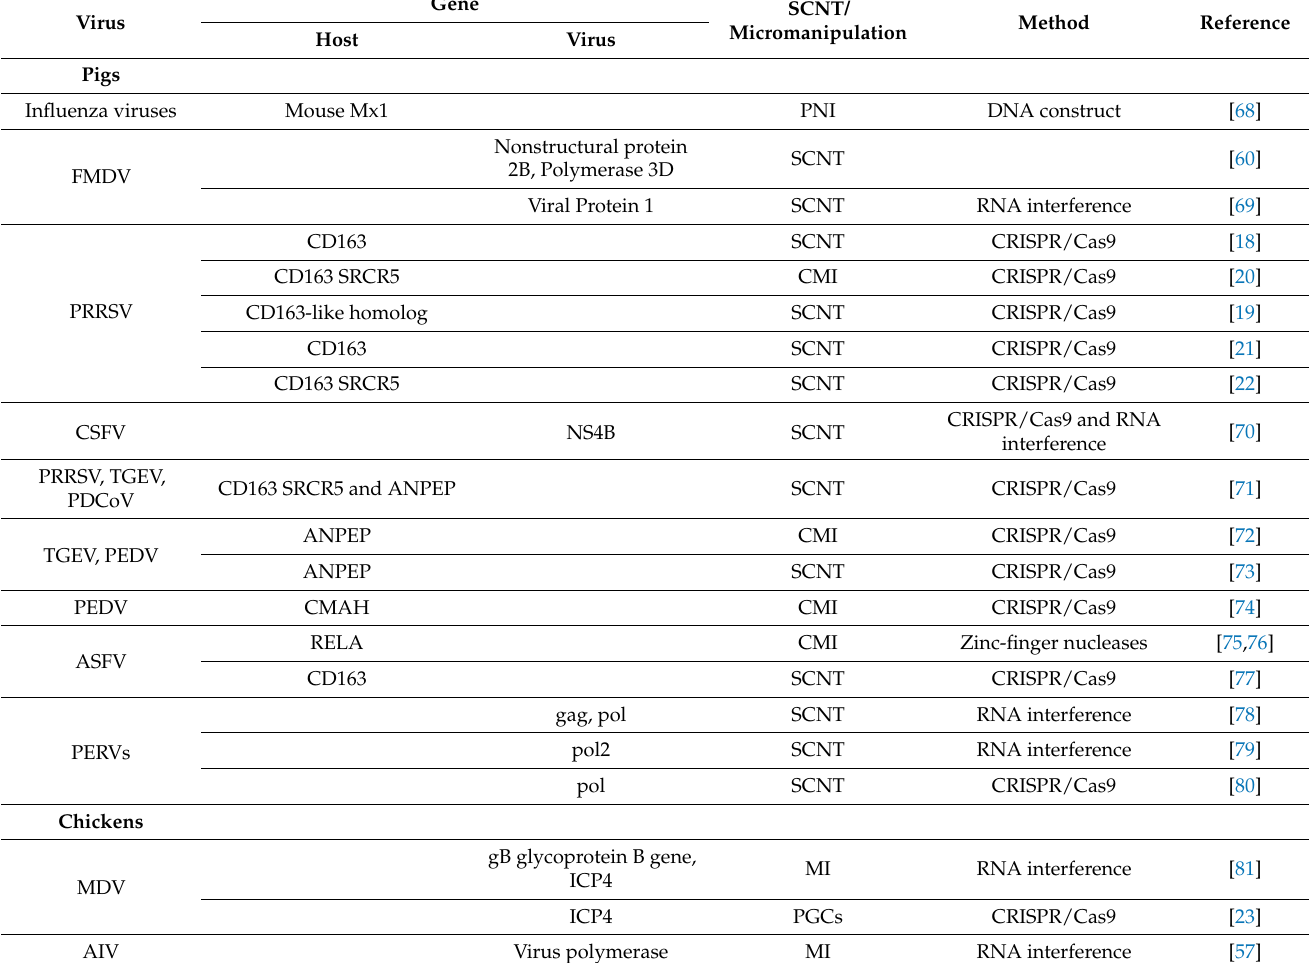
Table 1. Studies investigating viral resistance/resilience in